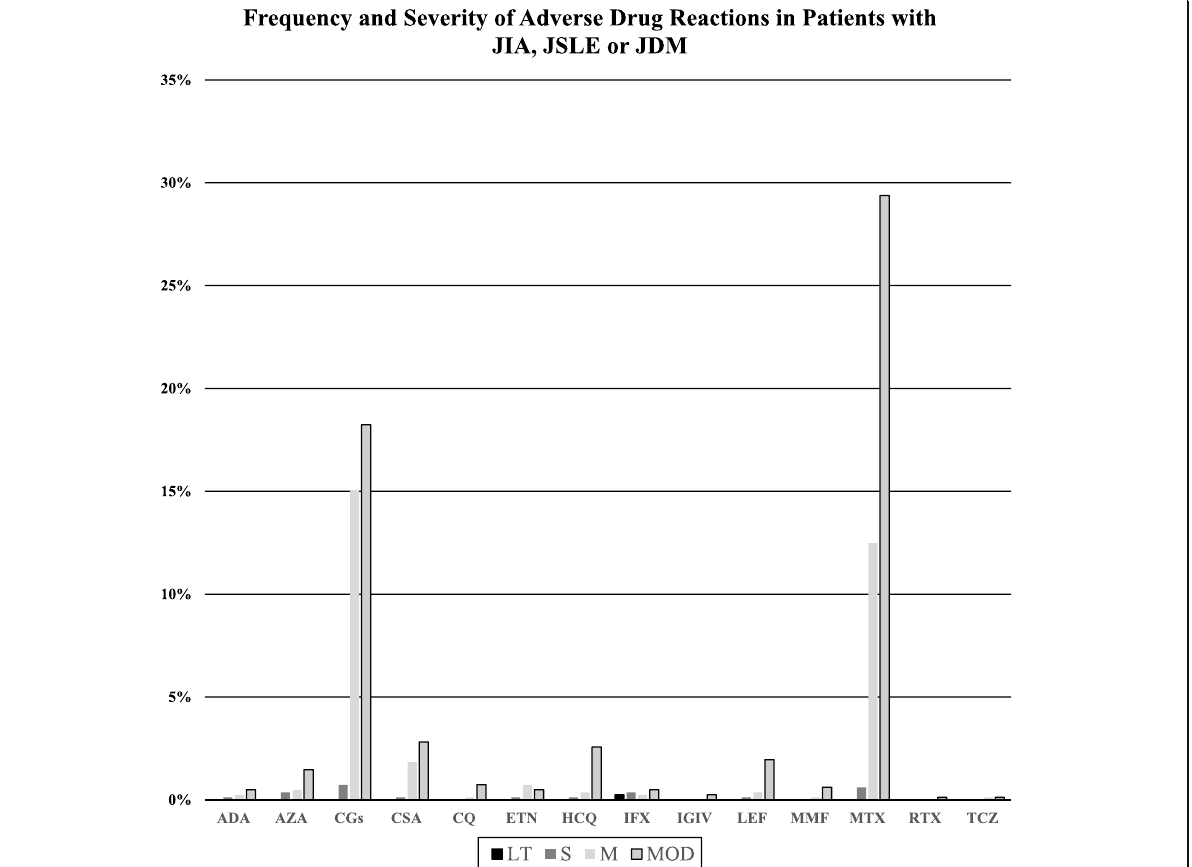
Fig. 1 Frequency and severity of adverse drug reaction. Frequency and severity of ADRs of medication used in patients with JIA, JSLE, and JDM. The vertical axis shows the percentage of adverse drug reactions of each medication. The horizontal axis shows the degree of severity of adverse drug reaction. ADR – adverse drug reaction. JIA – juvenile idiopathic arthritis. JSLE – juvenile systemic lupus erythematosus. JDM – juvenile dermatomyositis. LT – life threatening adverse event; S – severe adverse drug reaction; M – mild adverse drug reaction; MOD – moderate adverse drug reaction. % - percentage. ADA – adalimumab. AZA – azathioprine. CPA – cyclophosphamide. GCs – glucocorticoids. CSA – cyclosporine. CQ – diphosphate chloroquine. ETN – etanercept. HCQ – hydroxychloroquine. IFX – infliximab. IVIG – intravenous immunoglobulin. LEF – leflunomide. MMF – mycophenolate mofetil. MTX – methotrexate. RTX – rituximab. TCZ –